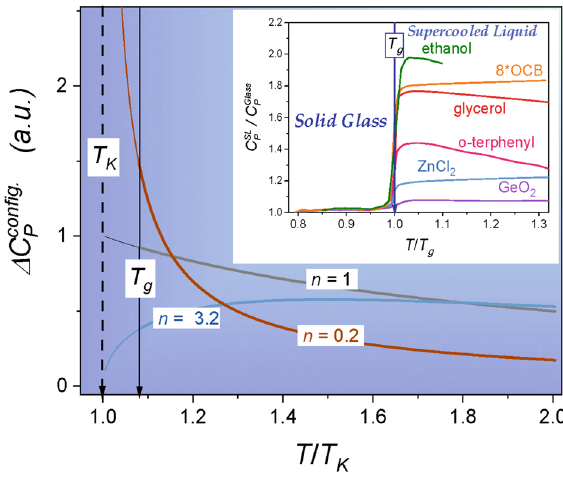
Figure 5. Previtreous temperature dependencies of configurational component of heat capacity in supercooled glass-forming liquids. The values resulted from Eq. (4), present different parameters n . Thin curves are for the extrapolation into the solid glass state. The inset shows examples of patterns of heat capacity changes for a selected cooling rate: prepared based on Refs. 67,68